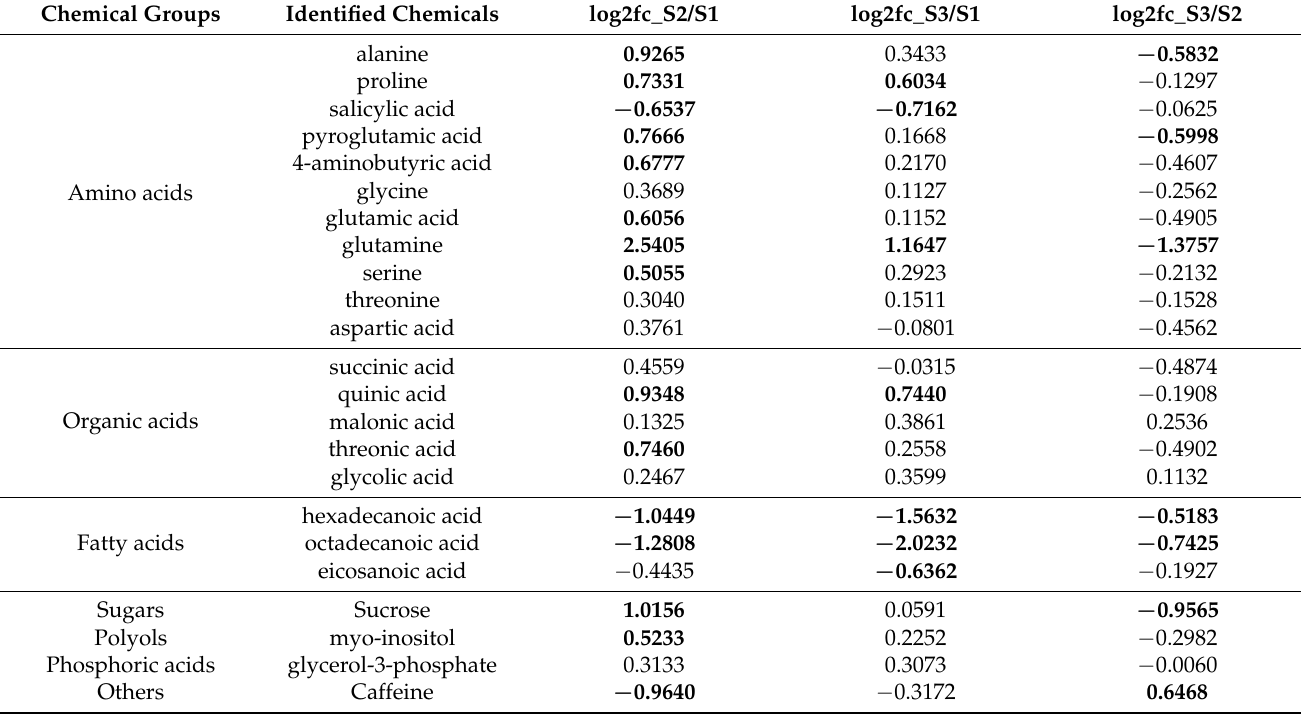
Figure 2. Network map of correlation analysis among difference metabolites: ( a ) S1 vs. S2; ( b ) S1 vs. S3; ( c ) S2 vs. S3. Metabolites are represented by circles. The same color indicates metabolites in the same metabolic function group. Correlations are shown by connected lines. Red lines are positive correlations, and blue lines are negative correlations. Table 1. Metabolite changes based on comparisons of different chemical